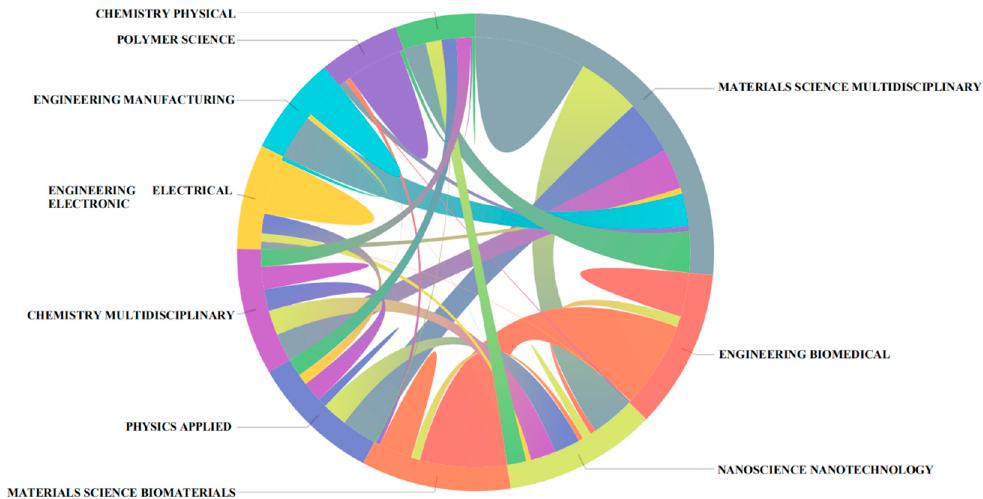
Figure 6. The intersection matrix map among leading research areas.